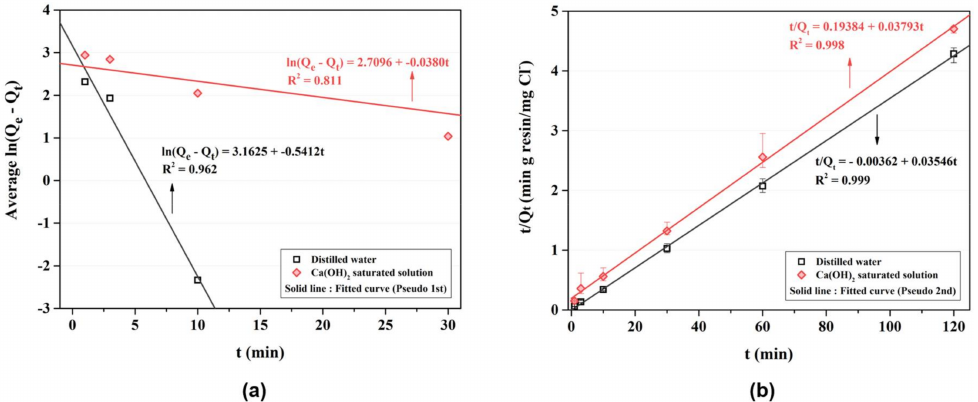
Figure 4. Results of the kinetic test—linear curve: ( a ) pseudo first-order reaction equation; ( b ) pseudo second-order reaction equation.